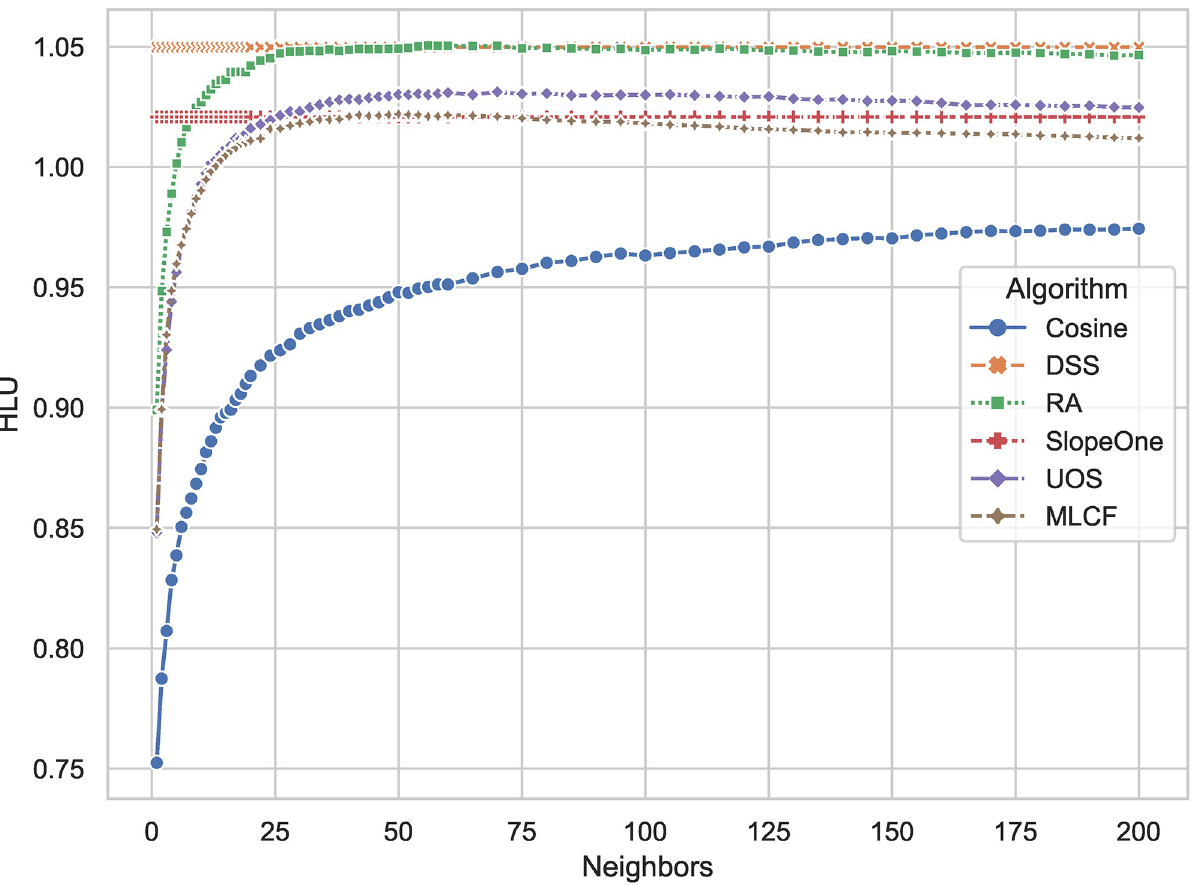
Fig 5. HLU comparison results of DSS and other algorithms. The larger the result, the higher the probability that the algorithm give a recommendation list with the items that the user likes at the top.